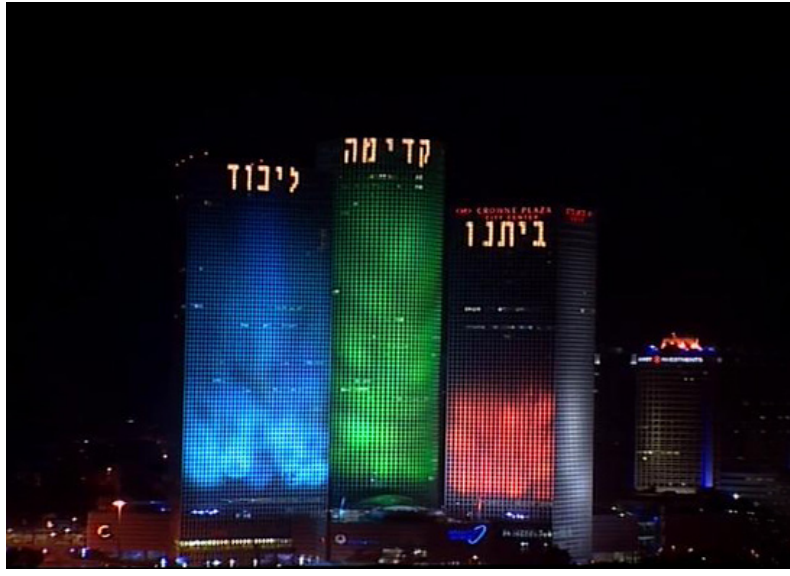
Projection of the 2009 election’s exit polls on the Center’s façade [credits: News 13,